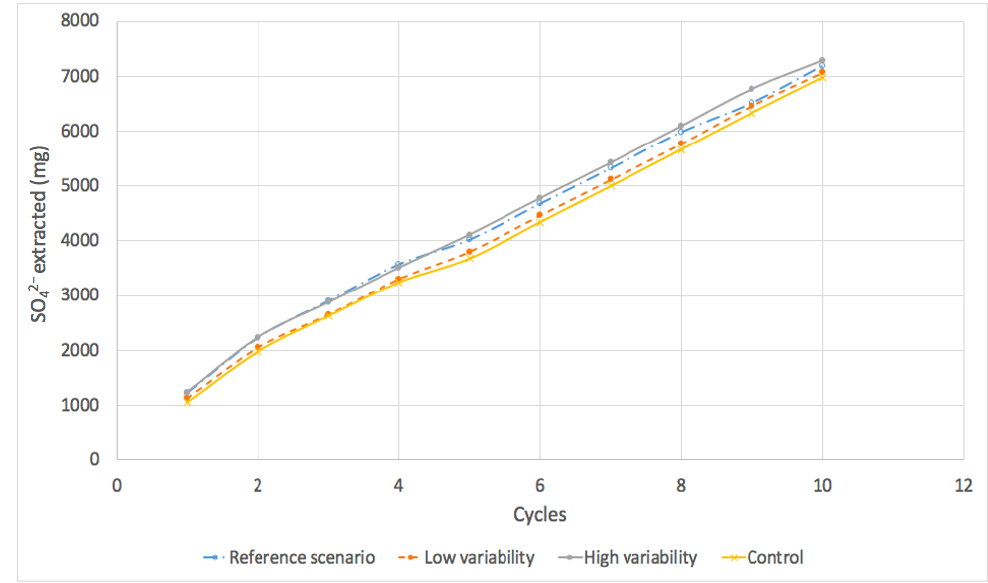
Figure 8. Cumulated mass of SO 42 − collected in the leachate for each tested scenario. For the reference, low variability and high variability scenarios, results correspond to the average cumulated masses of the duplicates. Next to each curve is indicated the final cumulated mass of sulfate extracted, expressed as percentage of total sulfate in the pristine tailings.